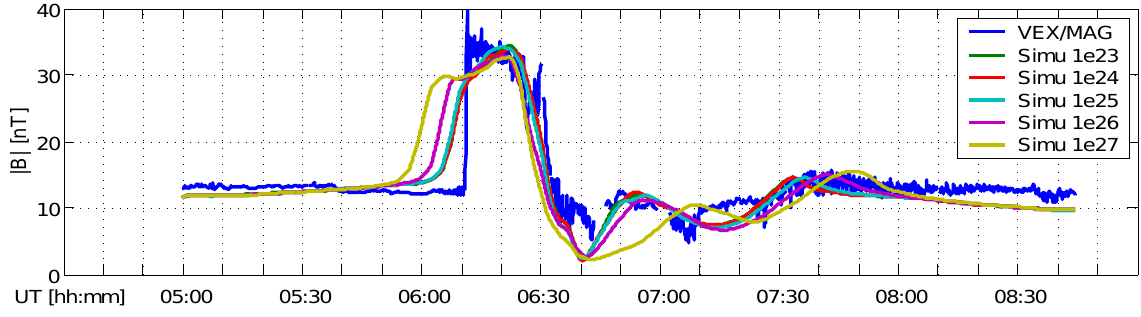
Fig. 5. The magnitude of the magnetic field at the y = 0 plane in three HYB-Venus simulation runs with different O + emission rates are (from the left): 10 24 , 10 25 (nominal) and 10 26 s − 1 . The spacecraft’s trajectory is projected into the plane.